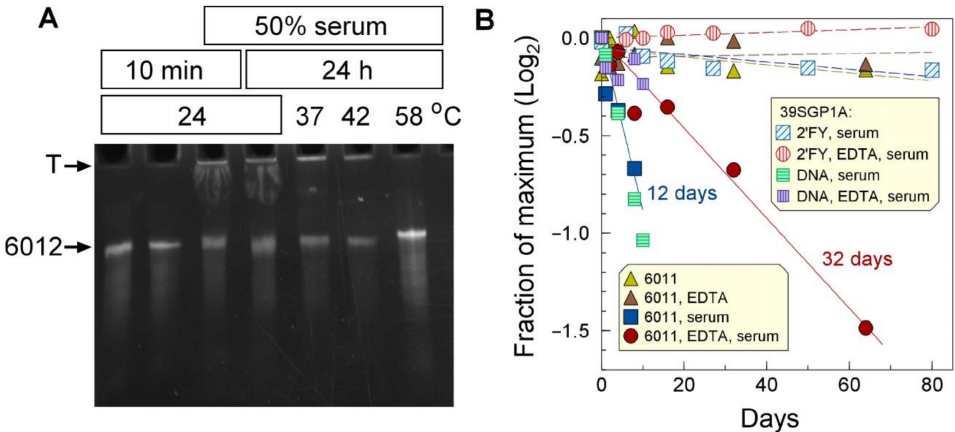
Figure 6. Stability of aptamers in relation to temperature and serum components . ( A ) Twenty- micromolar oligonucleotide 6012 was incubated in PBS at the temperatures and for the times shown in the figure, with or without 50% human serum. ( B ) Thirty-micromolar 6011 was incubated at 24 ◦ C for the identified times in BSM1C with and without 2 mM EDTA (gold and brown triangles). Sixteen-micromolar 6011 was incubated at 24 ◦ C in PS, 10mM NaN 3 , and 50% bovine serum in the presence or absence of 1 mM EDTA (blue and red-filled symbols). Forty-micromolar 39SGP1A was incubated at 24 ◦ C for the identified times in RSBA and 50% bovine serum, in the presence or absence of 1 mM EDTA (vertically hatched red circles, diagonally hatched blue squares, respectively). Forty-micromolar 39SGP1A as DNA was incubated at 24 ◦ C for the identified times in RSBA and 50% bovine serum, in the presence or absence of 1 mM EDTA (vertically hatched mauve squares, horizontally hatched green squares,